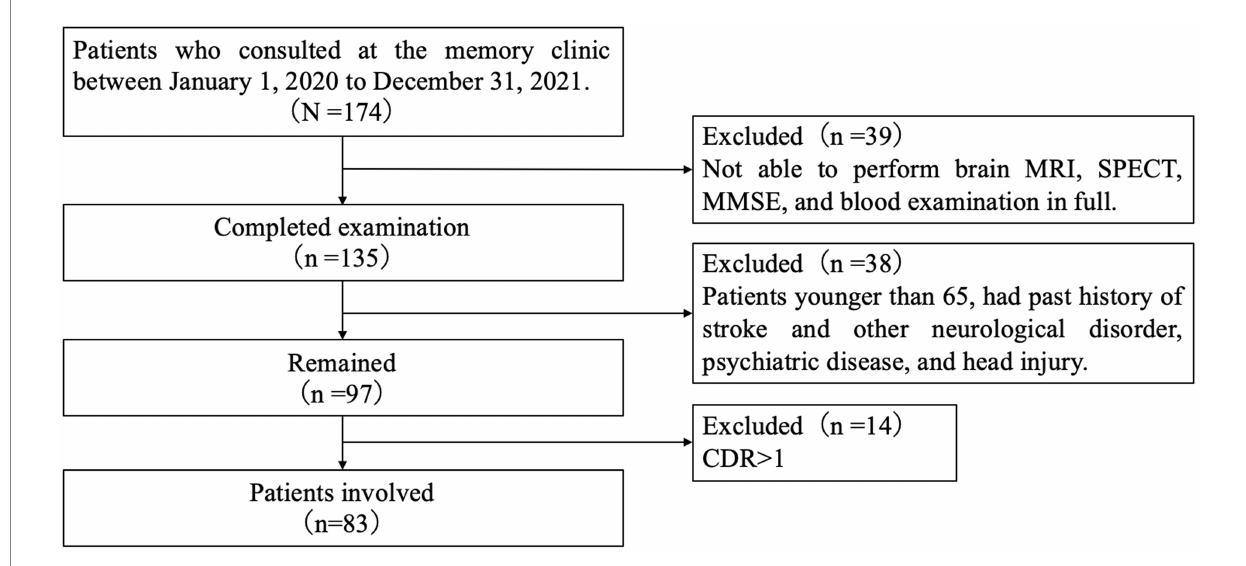
FIGURE 1 Flowchart of patient recruitment. MRI, magnetic resonance imaging; SPECT, single-photon emission computed tomography; MMSE, mini-mental state examination japanese version; and CDR, clinical dementia